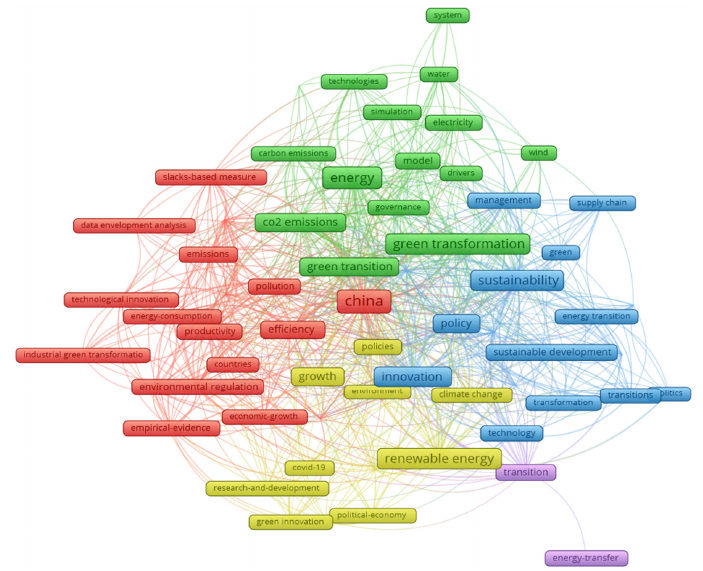
Figure 3. Map of links among keywords characterised by most frequent